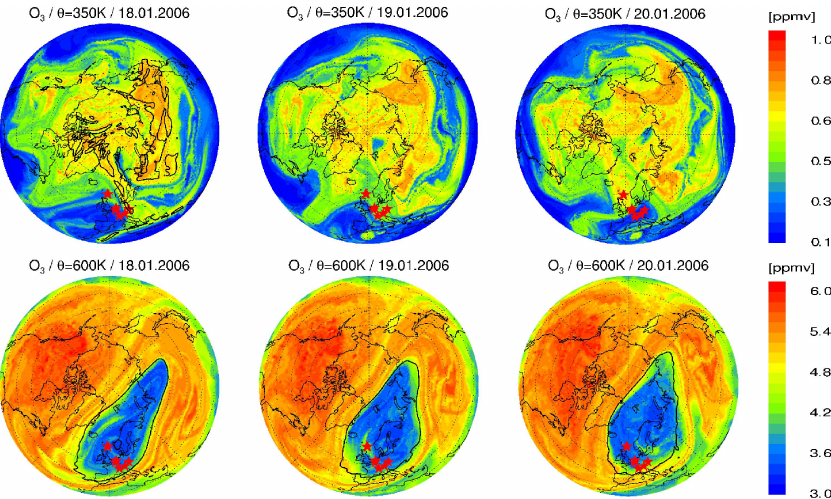
Fig. 10. Ozone mixing ratio in ppmv for 18, 19 and 20 January 2006, 12:00UT, for 2 = 350 (top row) and 2 = 600K (bottom row) as simulated by CLaMS; ozone sounding stations marked by stars; boundary of the polar vortex marked by the thick black line; note the different scales for 2 = 350 and 600K.